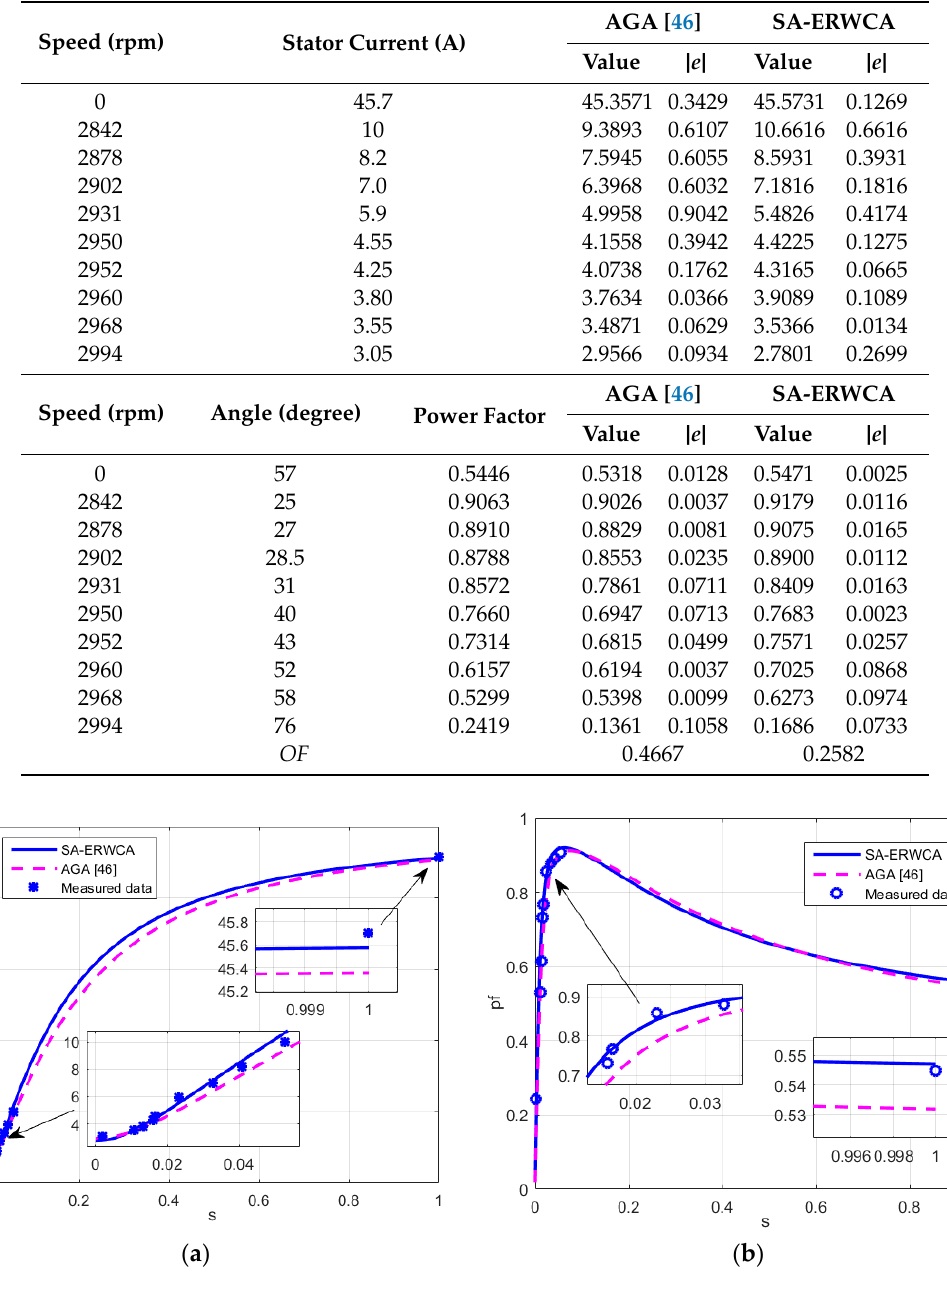
Figure 9. Curves of Machine 5: ( a ) Phase current versus slip; and ( b ) power factor versus